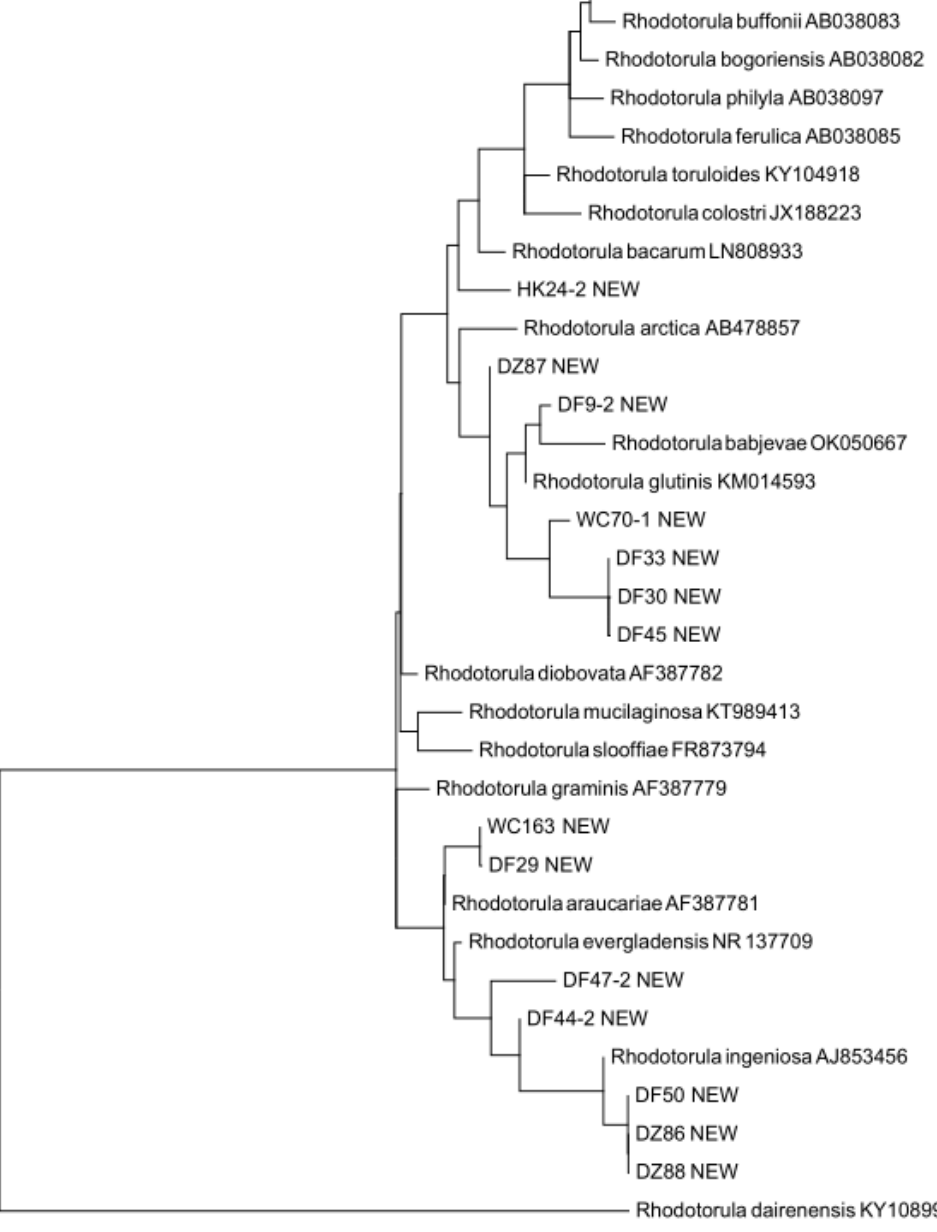
Figure 4. Maximum likelihood tree showing the relationships between nine putative novel Rhodotorula species and their closely related known species based on rDNA ITS sequences. The geographic origins of these putative novel species in our sample are indicated as two-letter abbreviations, where HK = Haikou, DZ = Danzhou, WC = Wenchang, and DF = Dongfang. The tree was constructed using RaxML with 1000 bootstraps.